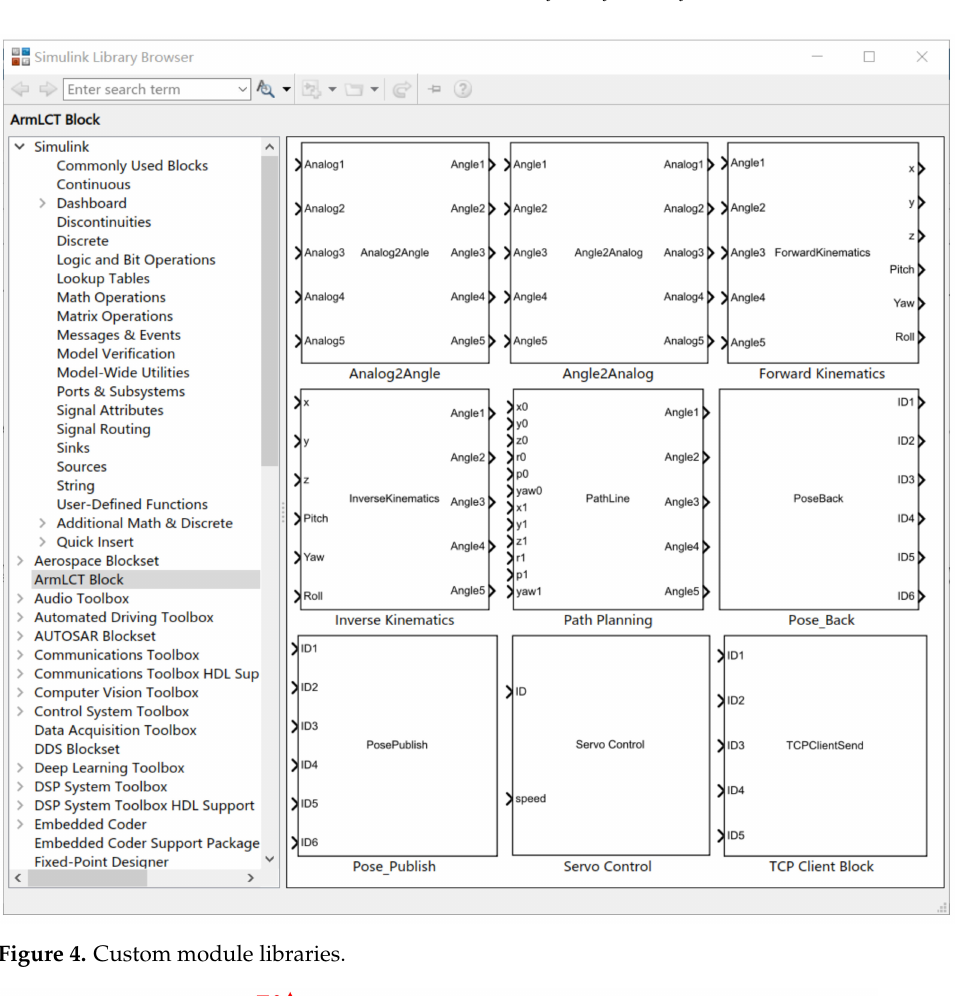
Figure 4. Custom module libraries.